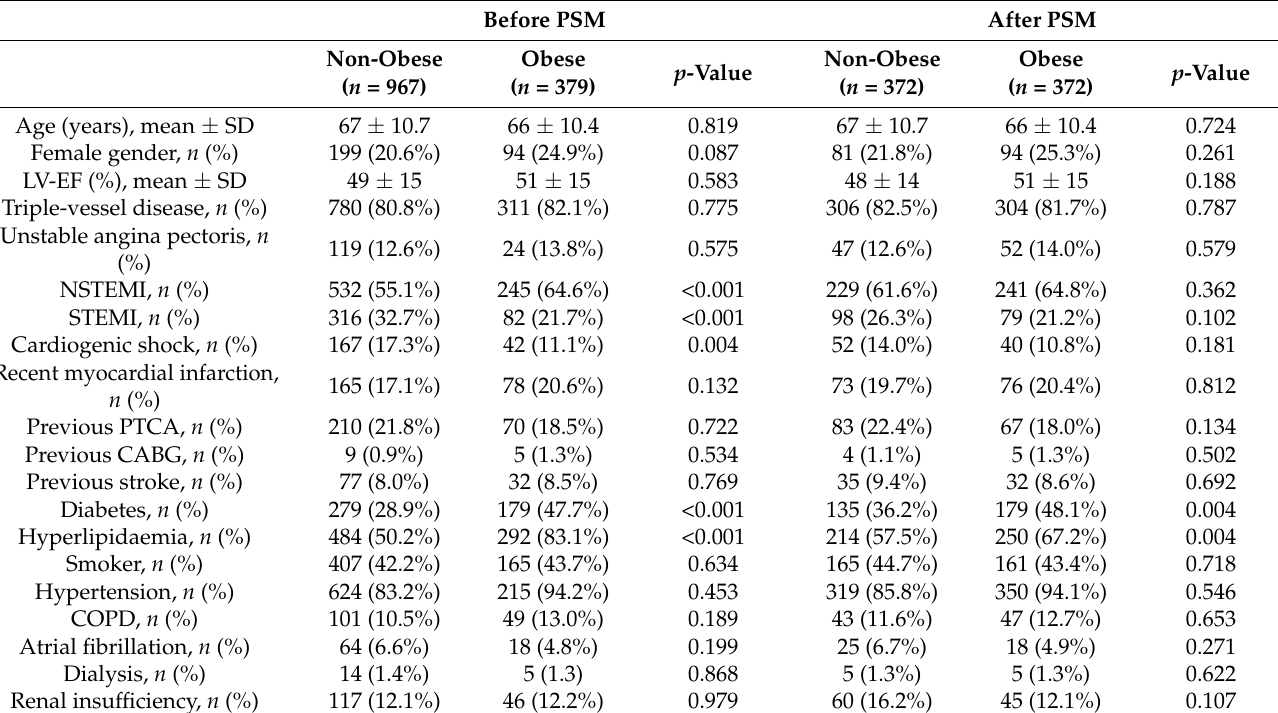
Table 1. Patient’s baseline preoperative demographics ( n = 1346 before PSM and n = 744 after PSM). Before PSM After